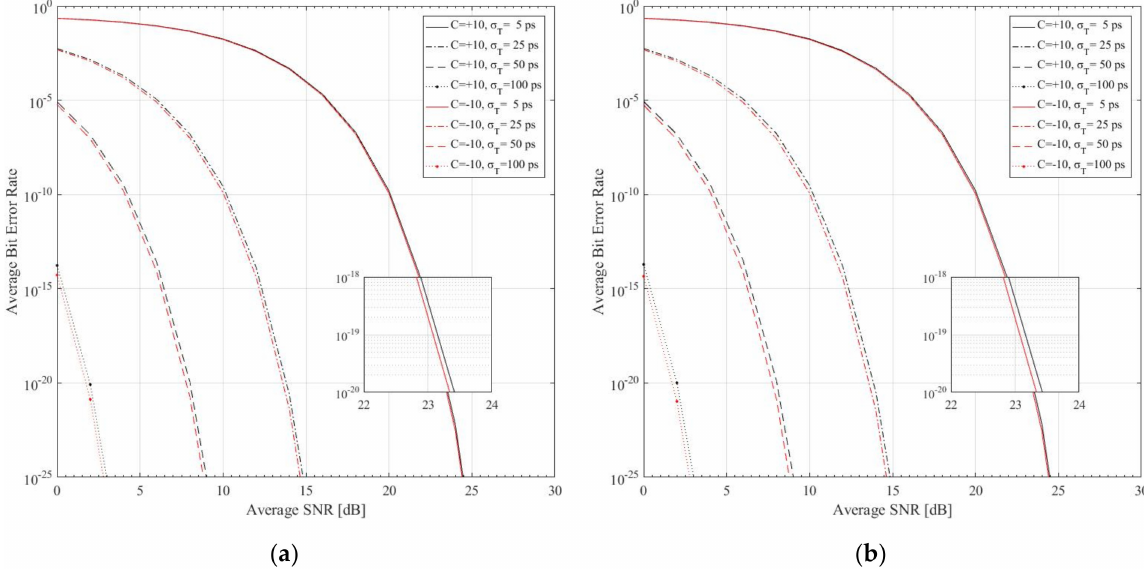
Figure 7. Average BER of a 100 Mbps link as a function of the average SNR, with T 0 = 10 ps, as detected after ( a ) 8 km and ( b ) 10 km propagation